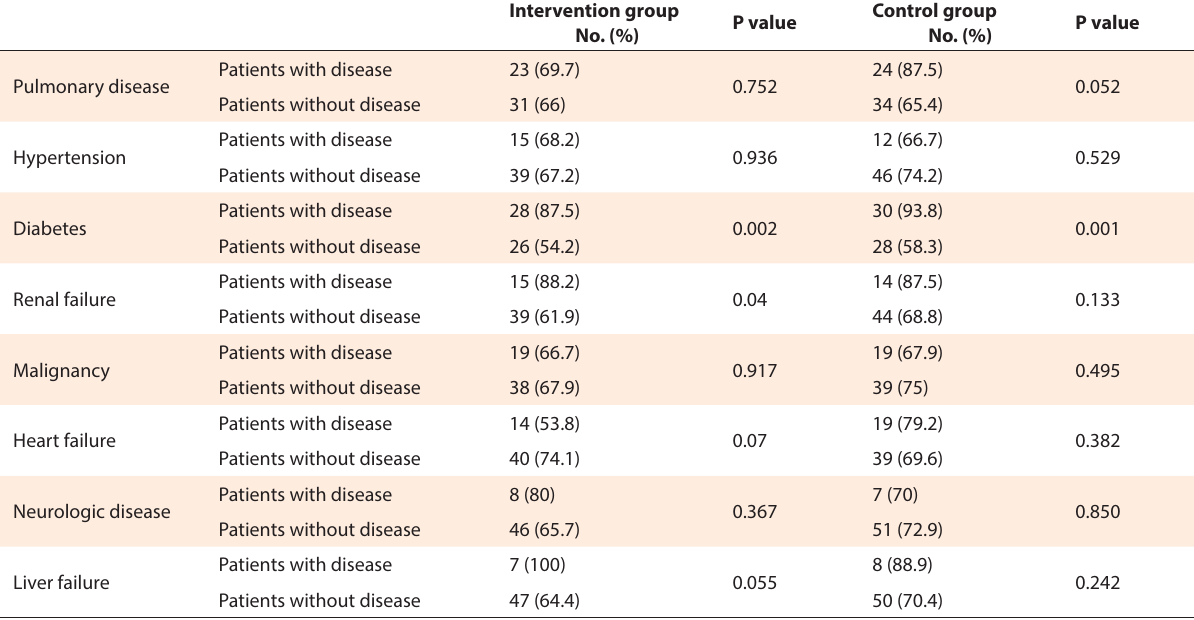
Intervention group Control group P value P No. (%) No. (%)